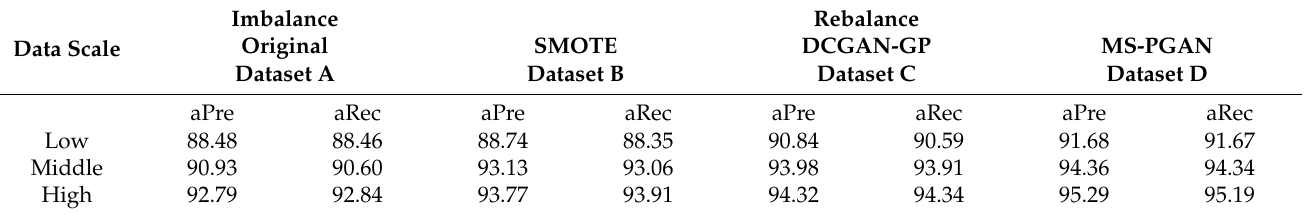
Figure 11. Comparison of the local noise interpolation used in the progressive generation: ( a ) a signal before using local noise interpolation; ( b ) a signal after using local noise interpolation; ( c ) the loss without local noise interpolation; ( d ) the loss using the local noise interpolation. Table 6. The average precision and recall (%) of the imbalanced and rebalanced datasets by SVM.